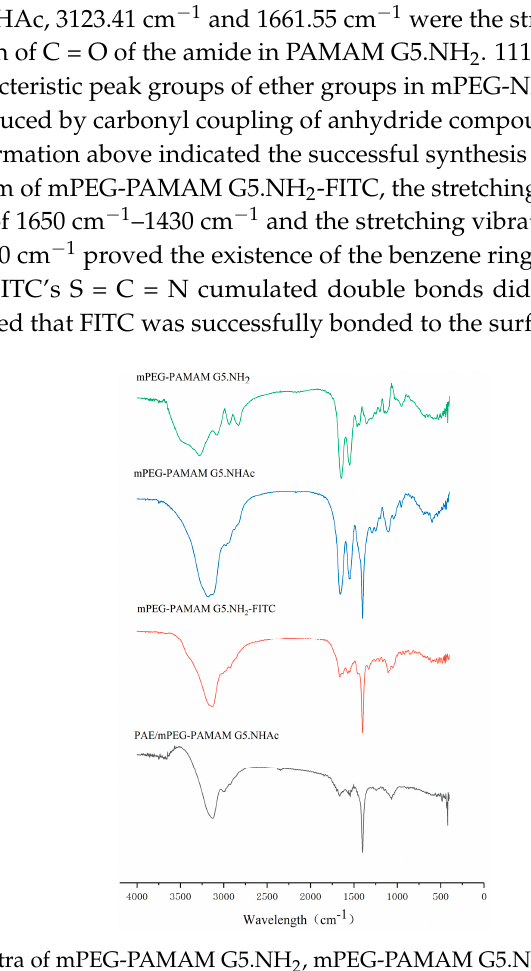
Figure 1. FTIR spectra of mPEG-PAMAM G5.NH 2 , mPEG-PAMAM G5.NHAc, PAE/mPEG-PAMAM G5.NHAc, and mPEG-PAMAM G5.NH 2 -FITC.